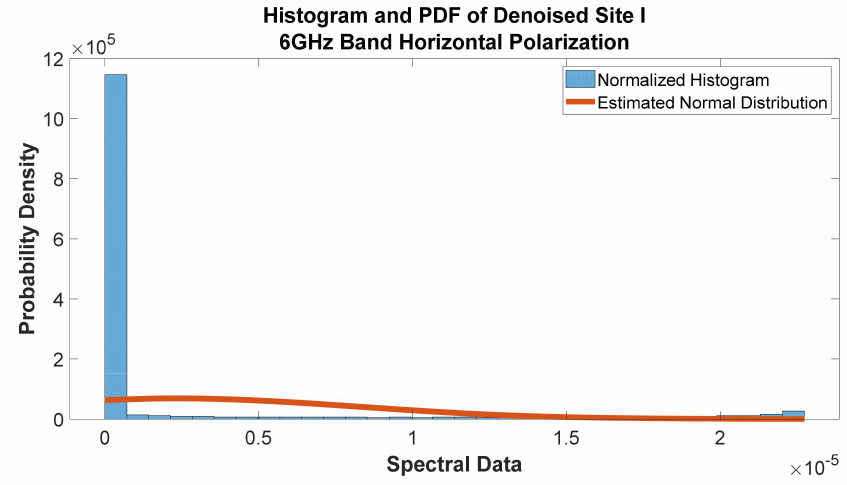
Figure 52. Histogram and PDF of Denoised Site I at 6 GHz band horizontal polarization.